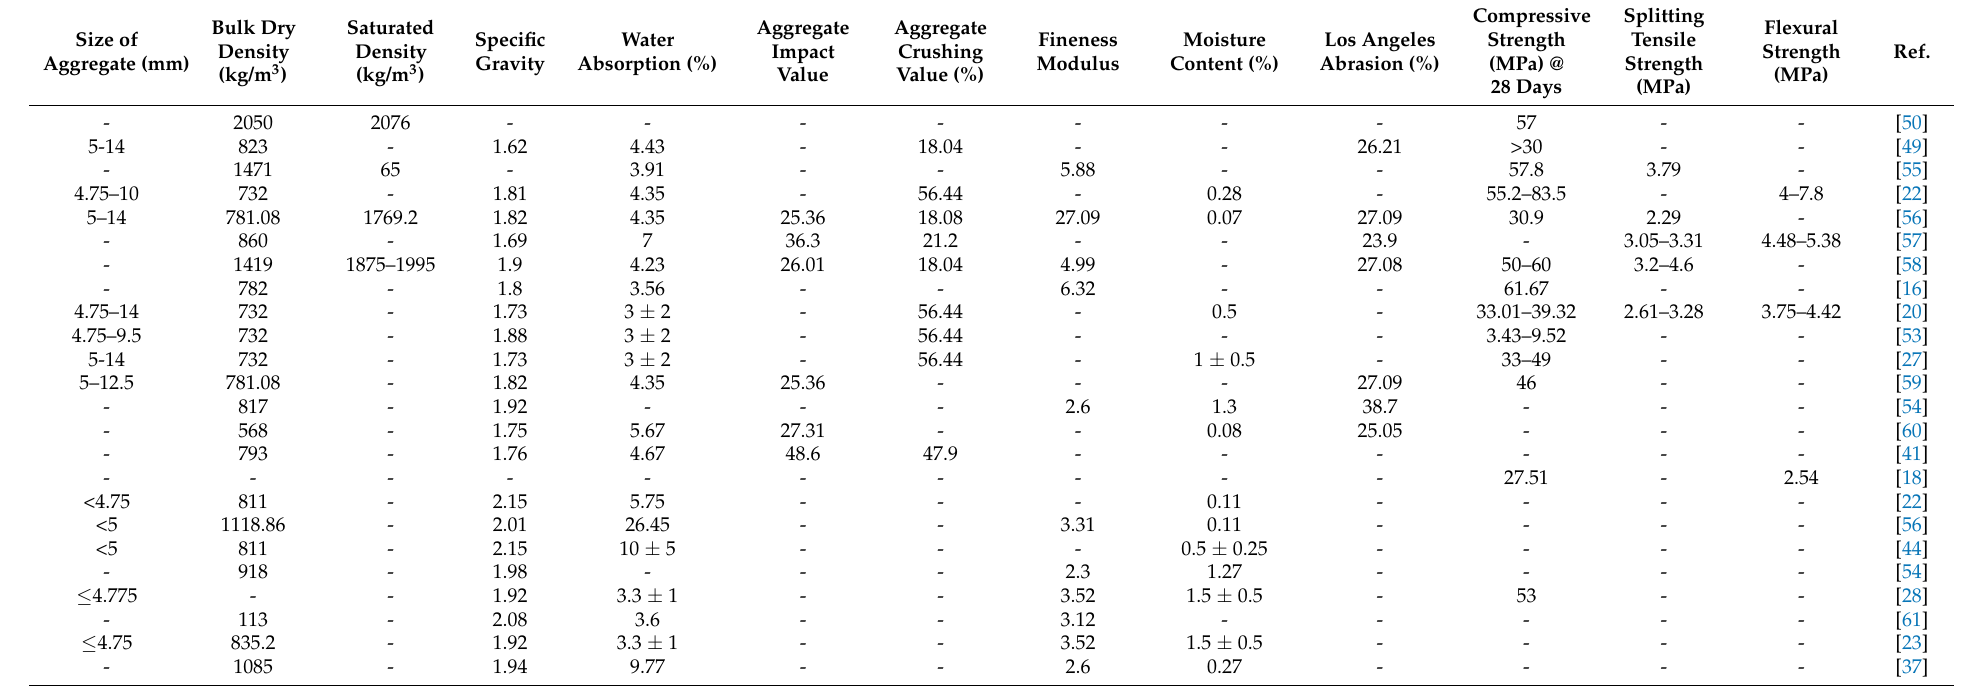
Table 4. Physical properties of